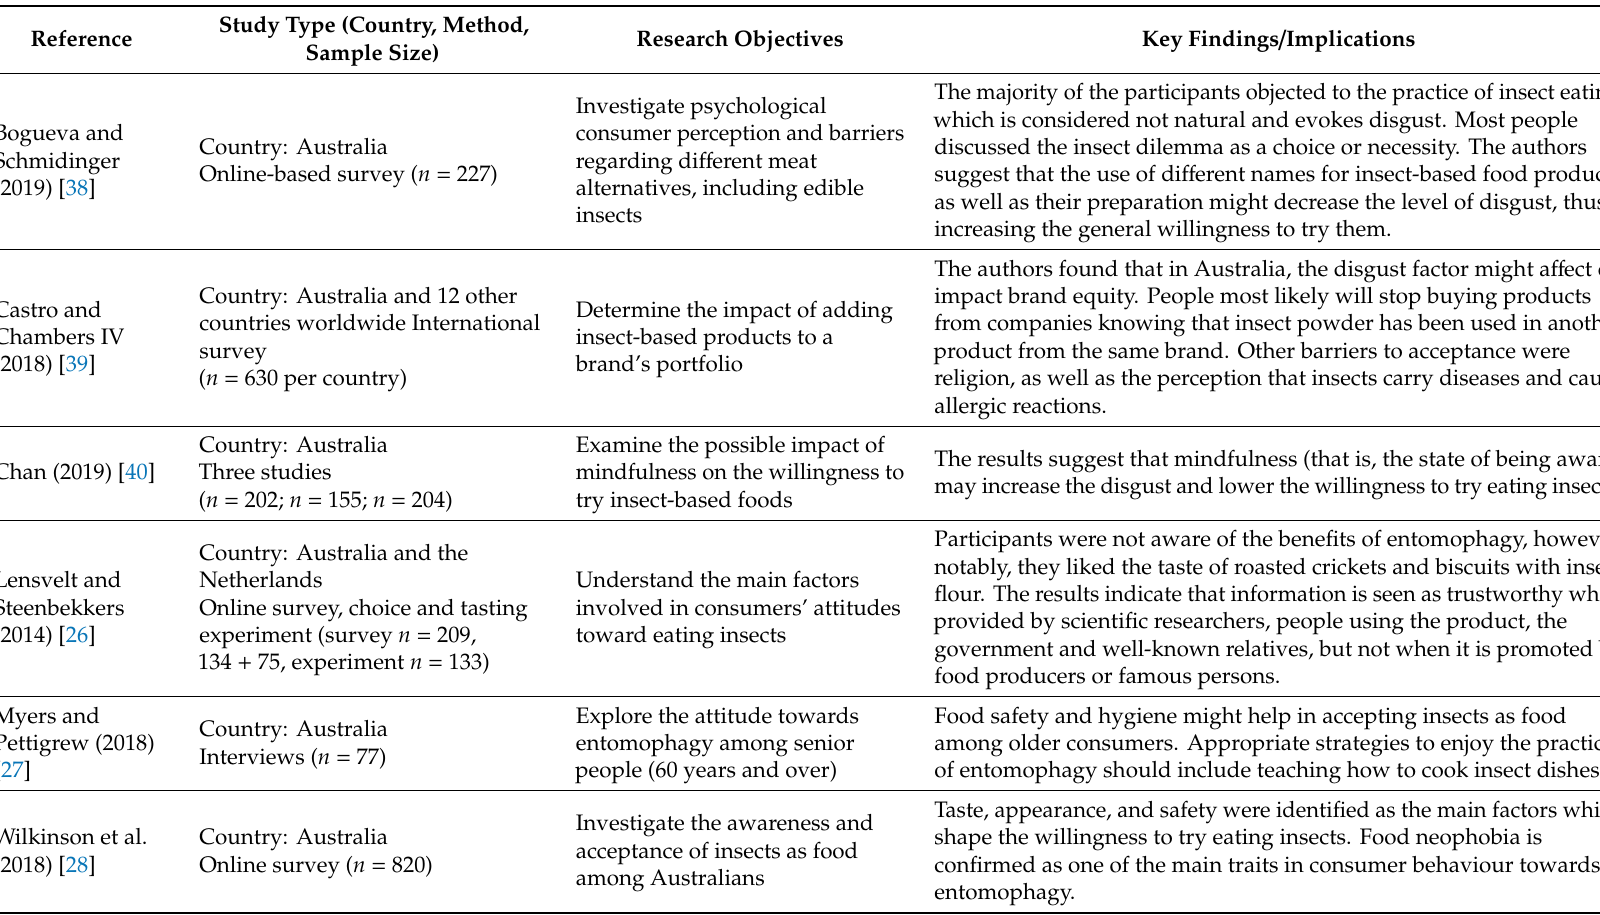
Table 1. Overview of the key studies on consumer perception and acceptance of insects as food in Australia and New